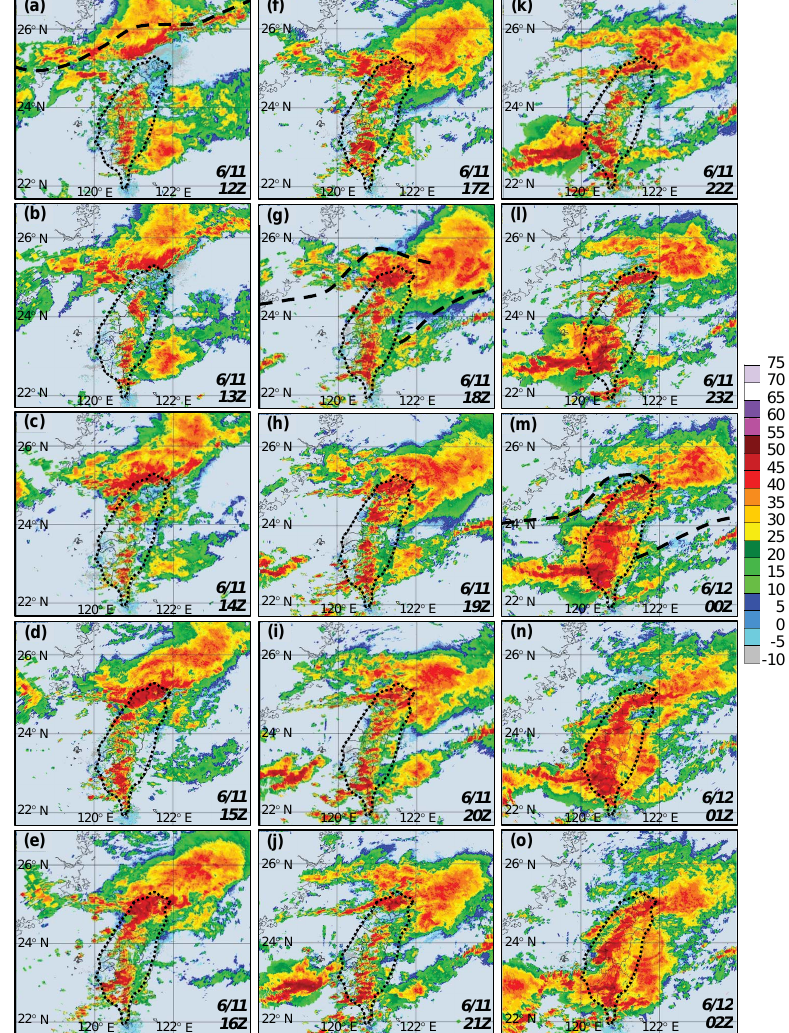
Figure 4. Composite VMI radar reflectivity (dBZ, color, scale to the right) over the Taiwan area at 1h intervals from (a) 12:00UTC on 11 June to (i) 02:00UTC on 12 June 2012. The outline of Taiwan is highlighted (thick dotted lines) and the surface frontal position is plotted at synoptic times (thick dashed